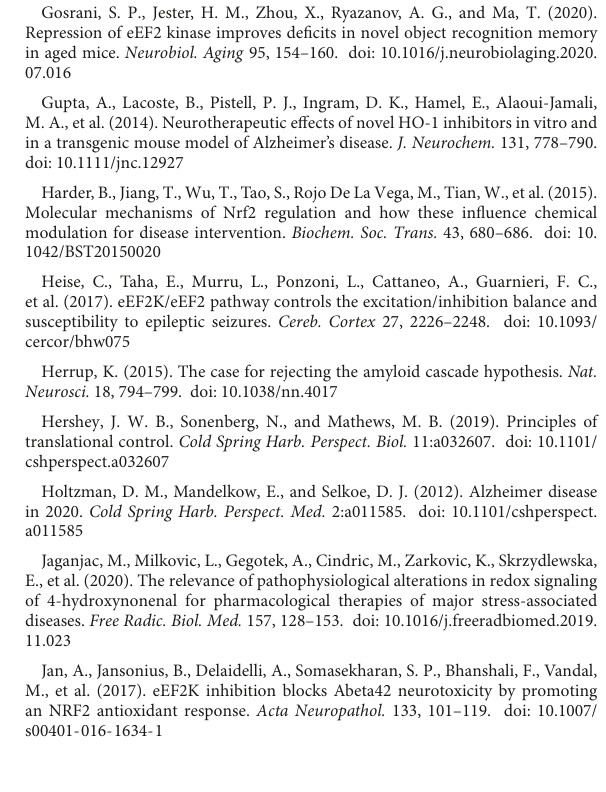
SUPPLEMENTARYFIGURE1 Levels of tau phosphorylation are not affected by genetic eEF2K knockout. Representative Western blots and quantification graphs showing levels of phosphorylated tau (Ser396) and total tau in hippocampal lysates from the 4 genotypes. No significant differences in levels of phosphorylated tau (Ser396) were detected across the 4 genotypes No significant differences in levels of total tau were detected (WT, n = 8; APP, n = 8; eEF2K − / − , n = 6; APP/eEF2K − / − , n = 5). SUPPLEMENTARYFIGURE2 Control behavioral data for APP/eEF2K − / − cohorts. (A) Left: Distance traveled in cm in the OF assay. Right: Velocity of movement in cm/s in the OF assay (WT, n = 17; APP, n = 9; eEF2K − / − , n = 10; APP/eEF2K − / − , n = 8). (B) Left: Distance traveled in cm in the MWM probe trial (WT, n = 16; APP, n = 9; eEF2K − / − , n = 16; APP/eEF2K − / − , n = 9). Right: Velocity of movement in cm/s in the MWM probe